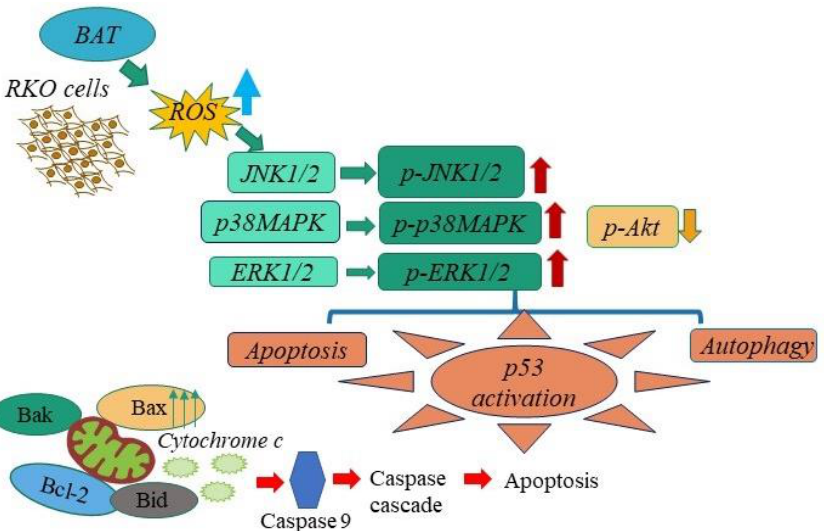
Figure 10. The scheme shows the underlying molecular mechanisms of BAT on colon cancer. BAT induces reactive oxygen species (ROS) accumulation, which in turn mediates mitochondrial apoptosis and autophagy. In BAT-treated RKO cells, mitochondrial apoptosis was induced through the upregulation of JNK½ , p38 MAPK, ERK½ kinases, and autophagy was stimulated via the activation of JNK½ kinases as well as the downregulation of